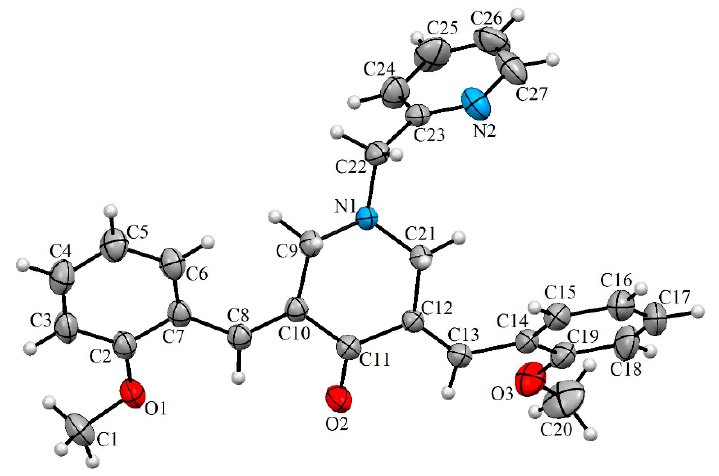
Figure 1. Oak Ridge Thermal Ellipsoid Plot (ORTEP) diagram of 5c .